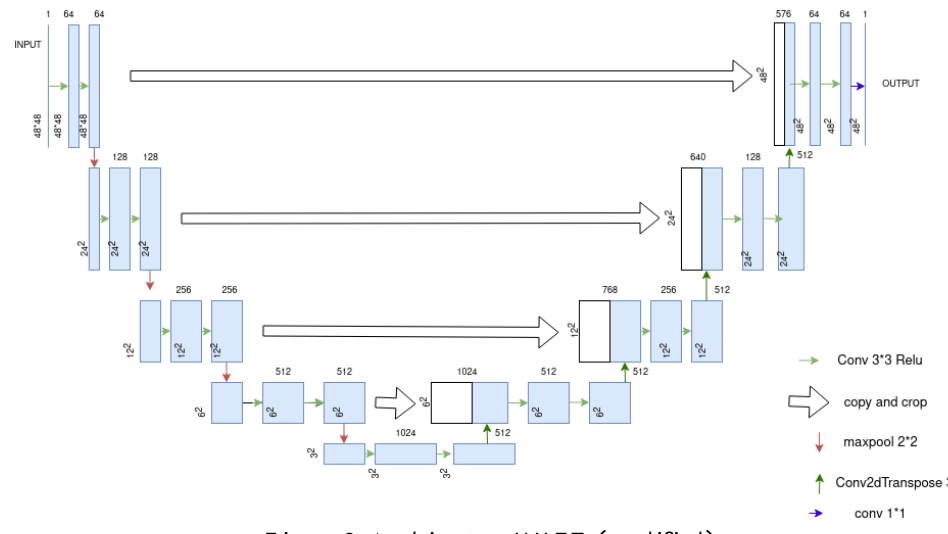
Figure 3. Architecture UNET